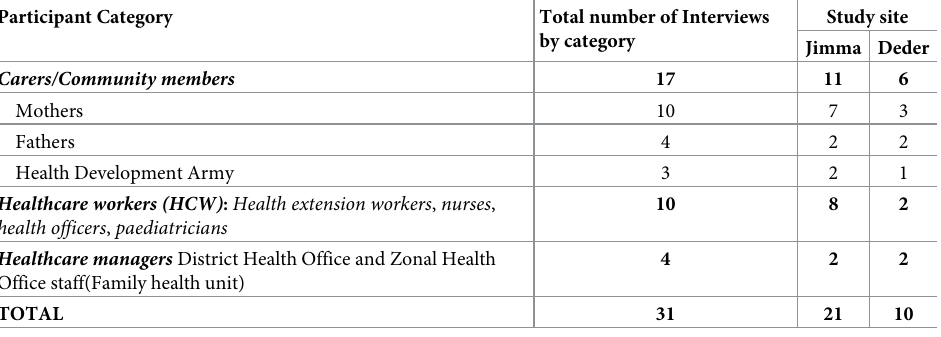
Table 1. Summary of study participants.